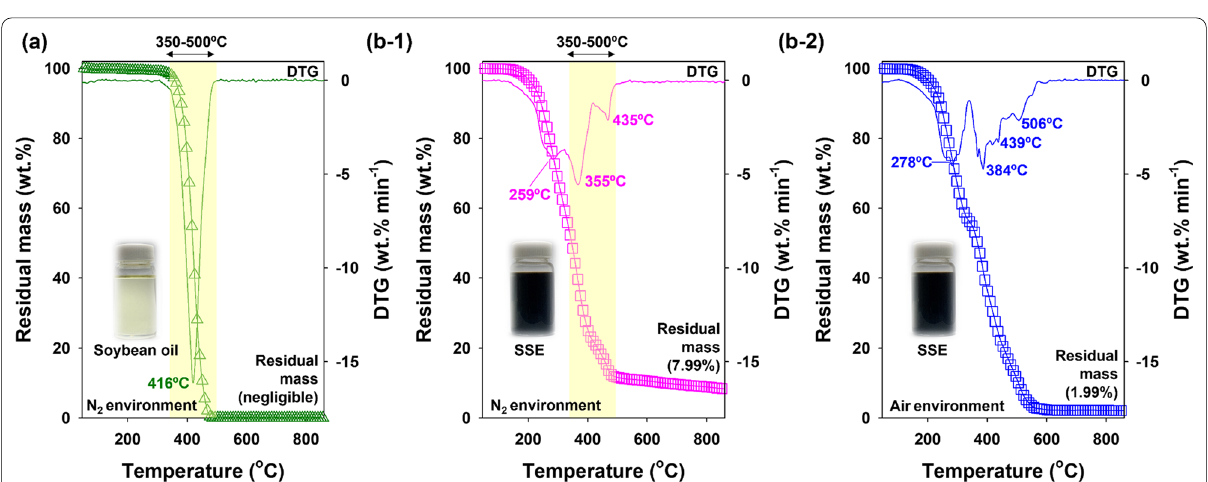
Fig. 2 Mass decay and differential thermogram (DTG) curves of ( a ) soybean oil and ( b-1 ) SSE under N 2 and ( b-2 ) SSE under air